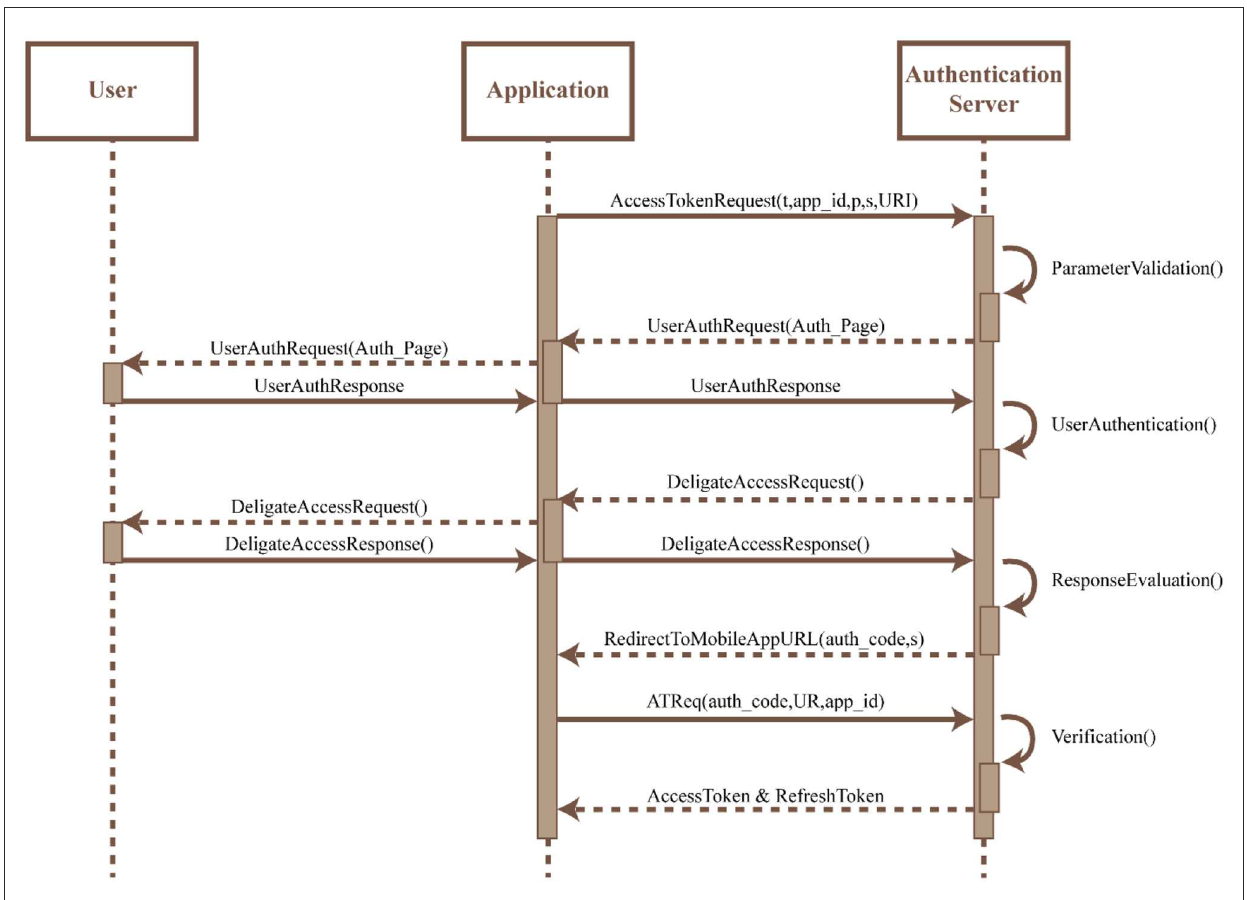
FIGURE8 Process flow diagram for OAuth2